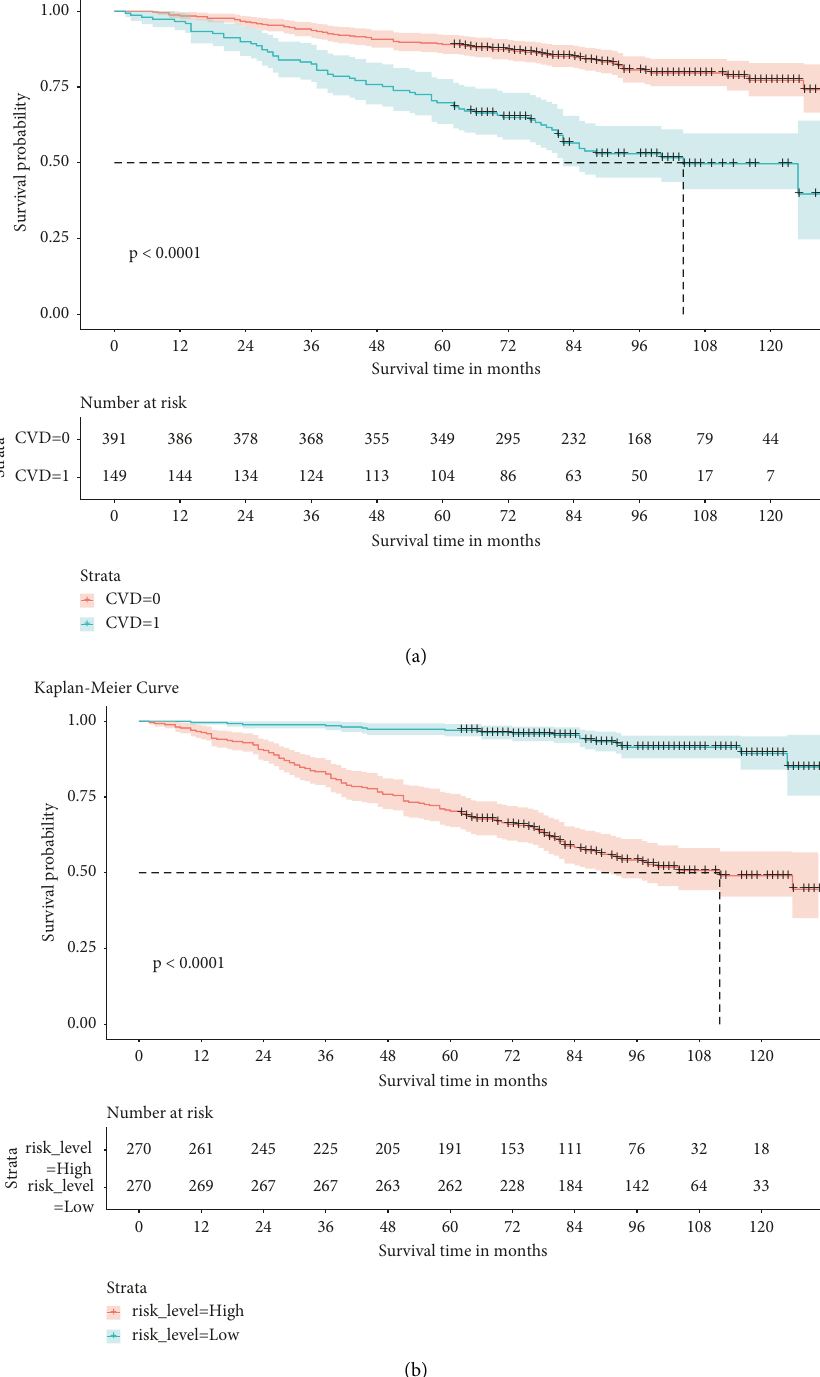
Figure 3: (a) Kaplan–Meier survival curves of CVD group in COPD. CVD � 0 means participants with COPD but without CVD, while CVD � 1 means participants with COPD coexisting with CVD. (b) Kaplan–Meier survival curves in high- and low-risk